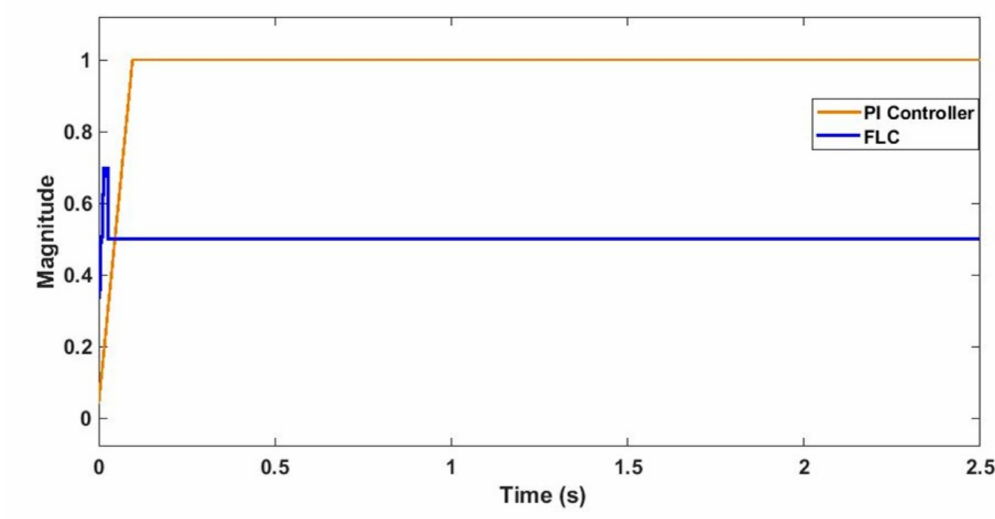
Figure 12. Comparison of step responses of PI controller and FLC.